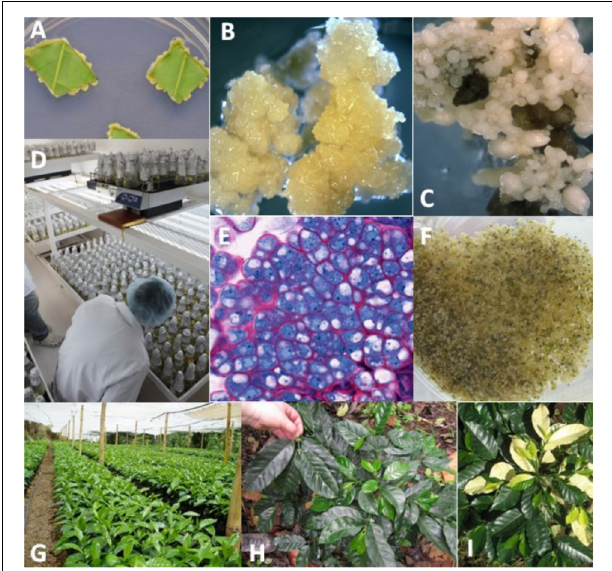
FIGURE 3 | Illustration of the production, multiplication, and plant regeneration from embryogenic cells in coffee ( C. arabica ). (A) Formation of a primary callus made of meristematic cells at the edge of leaf explants 3 weeks following in vitro introduction; (B) embryogenic callus obtained 6 months after in vitro introduction; (C) regeneration of somatic embryos from the embryogenic callus; (D) proliferation of embryogenic cell suspensions and subsequent regeneration of somatic embryos in Erlenmeyer flasks agitated on orbital shakers in an industrial coffee micropropagation laboratory (CIRAD/ECOM unit, Sebaco, Nicaragua); (E) histological appearance of embryogenic cell clusters in suspension cultures; embryogenic cells have a high nucleus cytoplasm ratio and dense cytoplasm rich in soluble and reserve proteins; (F) mass regeneration of torpedo-stage somatic embryos from embryogenic cell suspensions; (G) coffee SE-derived plants in the nursery (Cartago, Costa Rica); (H) “Dwarf” phenotypic variant (on the right) compared to a normal plant on the left; (I) “Variegata” phenotypic variant (from Etienne et al.,